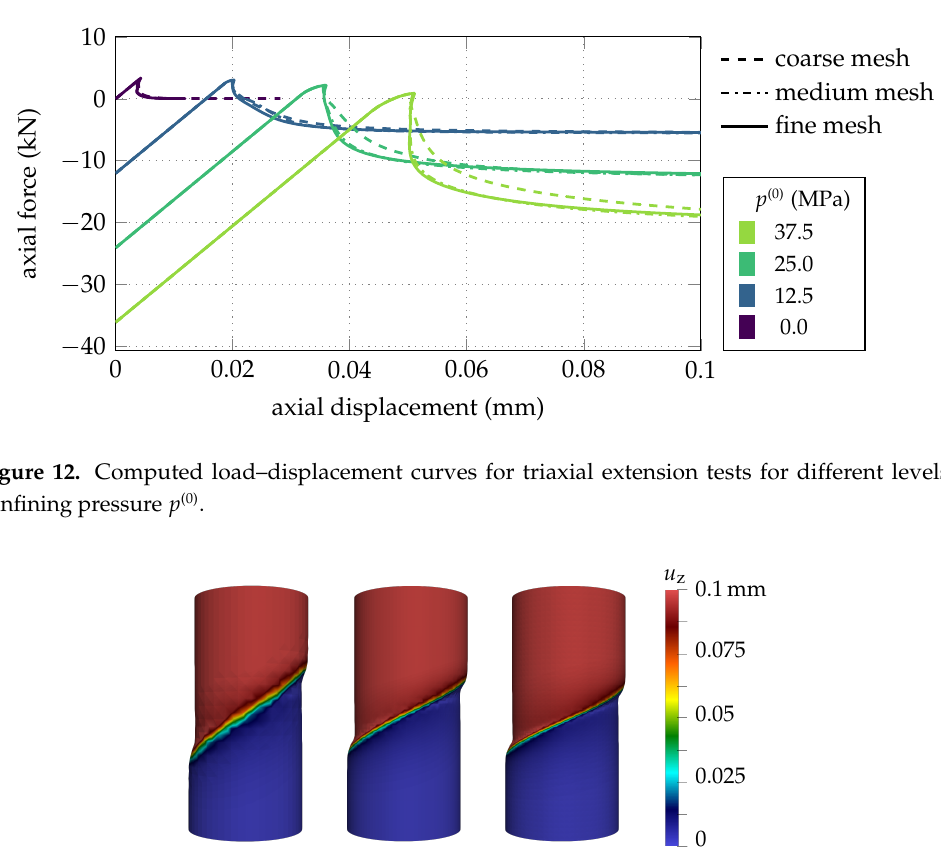
Figure 13. Distribution of the vertical displacement u z (deformation scale factor 10) at an applied top displacement of 0.1mm in the triaxial extension test with p (0) = 37.5MPa for the three finite element meshes: coarse ( left ), medium ( center ), and fine ( right